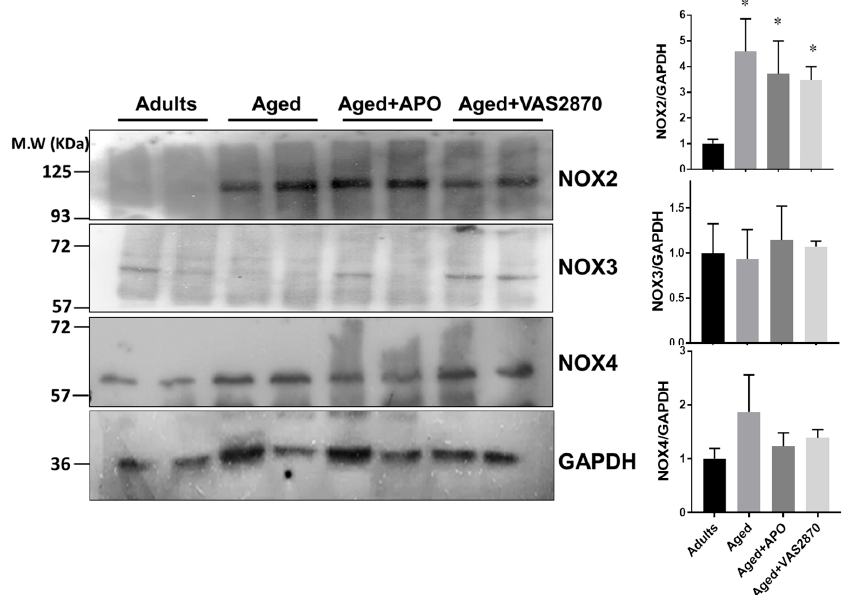
Figure 6. NOX isoforms expression. NOX isoforms expression was investigated by Western blotting. The left panels show representative Western blots of NOX isoforms (NOX2, NOX3, and NOX4) in cardiac homogenates from adults, aged, aged treated with apocynin 100 µmol/L (Aged + APO), and aged hearts treated with VAS2870, 20 µmol/L. GAPDH levels were used as loading control. The bar graphs depict average results normalized by GAPDH levels. N = 4 in each group. * p < 0.05 vs. adults.